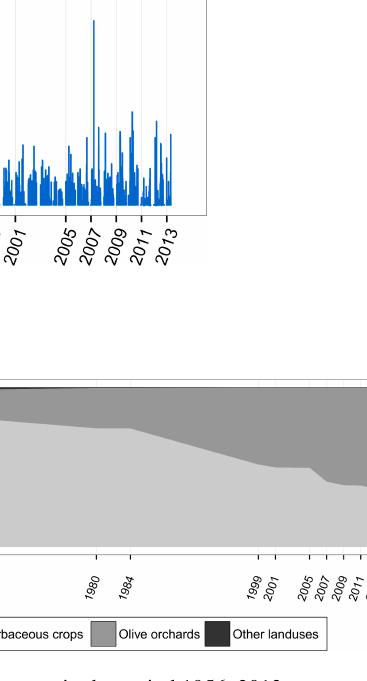
Figure 8. Land use changes in the period